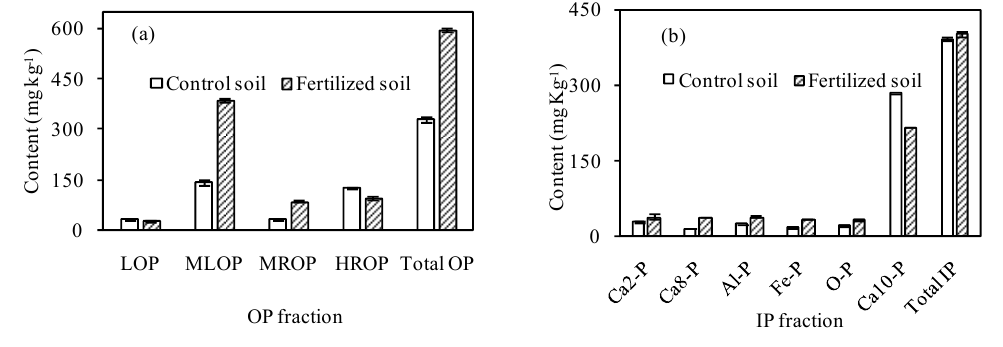
Figure 2. Fractionation of OP ( a ) and IP ( b ) in control and fertilized soils.